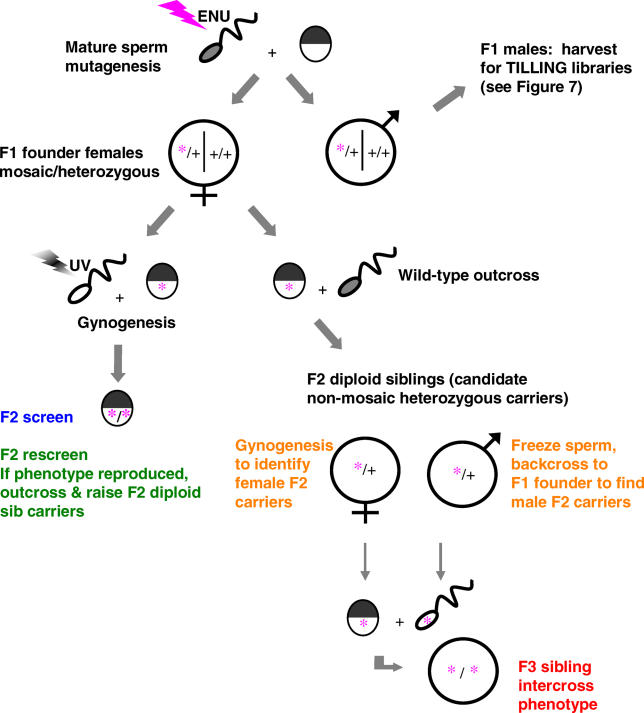
Forward Screen StrategyFollowing ENU mutagenesis of postmeiotic sperm and fertilization of wild-type eggs, a founder F1 generation was raised. Males were used in a reverse genetic strategy (see Figure 7). F1 females were used to generate gynogenetic embryos that were screened for embryonic defects. F1 females carrying defects were outcrossed and the resulting F2 embryos screened for carriers, then sibling intercrossed. Color code indicates status of specific mutations (see Figure 2 and Tables 2 and 3): red for phenotypes confirmed in the progeny of a conventional F2 sibling intercross, orange for phenotypes confirmed heritable by backcross or F2 gynogenesis, green for phenotypes observed twice from gynogenesis of an individual F1 female, and blue for phenotypes observed once and not yet retested.